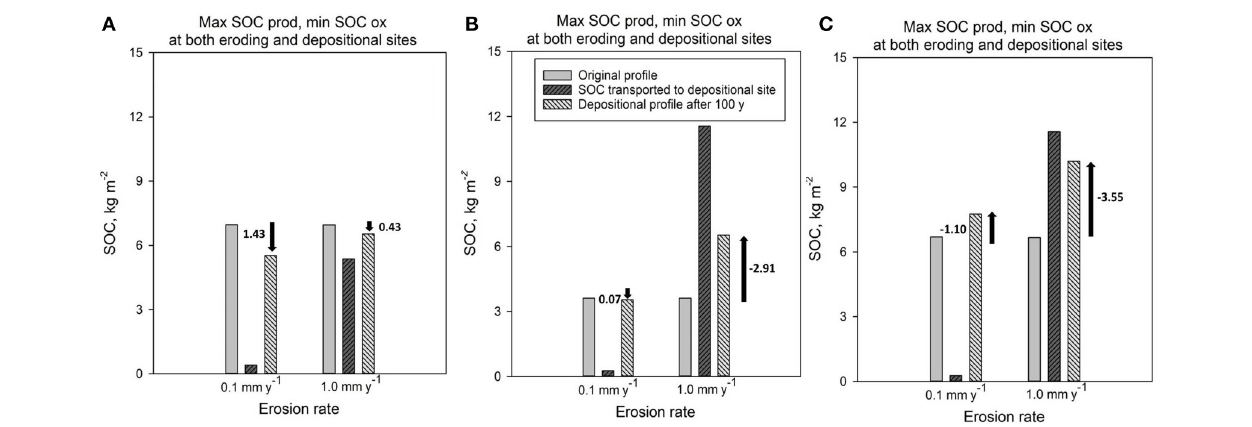
FIGURE 4 | Soil organic C content in depositional profiles prior to erosion onset (left most bar in each set), SOC content arriving at depositional sites (middle bar in each set), and SOC content in depositional profiles after 100 y (right-most bar in each set) at the specified erosion rates for boreal forest soils (A) and warm temperate forest soils (B,C) . In all scenarios, both eroding and depositional sites experienced maximized SOC production and minimized SOC oxidation upon erosion and deposition (see text for details of model parameterization). Boreal forest soil profiles (A) were 0.18m deep prior to the onset of deposition, and 0.19 or 0.28m deep after 100 y of deposition at 0.1 and 1.0mm y − 1 , respectively. In (B) , warm temperate forest soils were truncated at the same depth as the boreal forest soils (A) to enable direct comparison across these forests; (C) reflects the top 1.01 (0.1mm y − 1 ) and 1.1 (1.0mm y − 1 ) of depositional profiles in the warm temperate forest to enable projection of more realistic fluxes in these deep soils. Arrows reflect net SOC loss from profile (downward arrows) or net SOC gain to profile (upward arrows); numbers represent corresponding net SOC source to atmosphere or net SOC sink, respectively. Note that middle bars in each set remain constant across (B,C) , because SOC amount deposited does not depend on depositional site conditions.